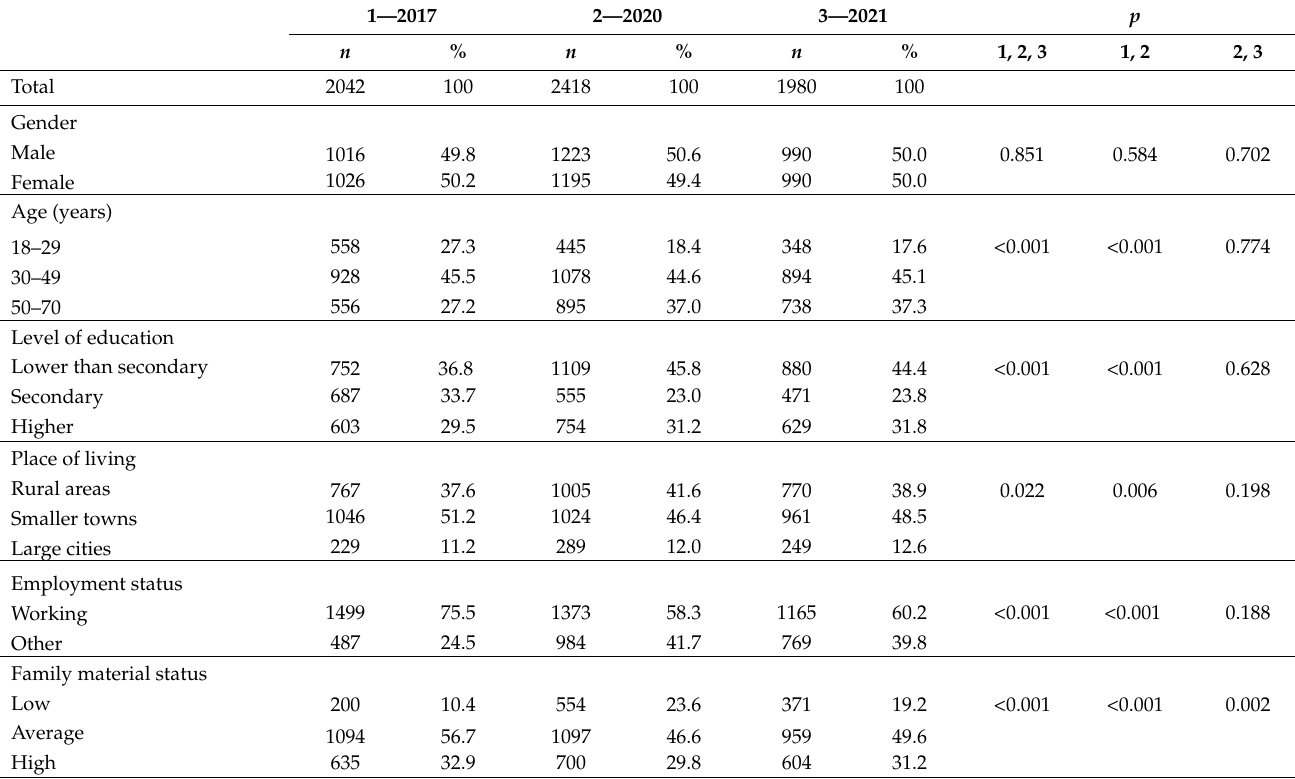
Table 1. Characteristics of respondents participating in the 2017, 2020, and 2021